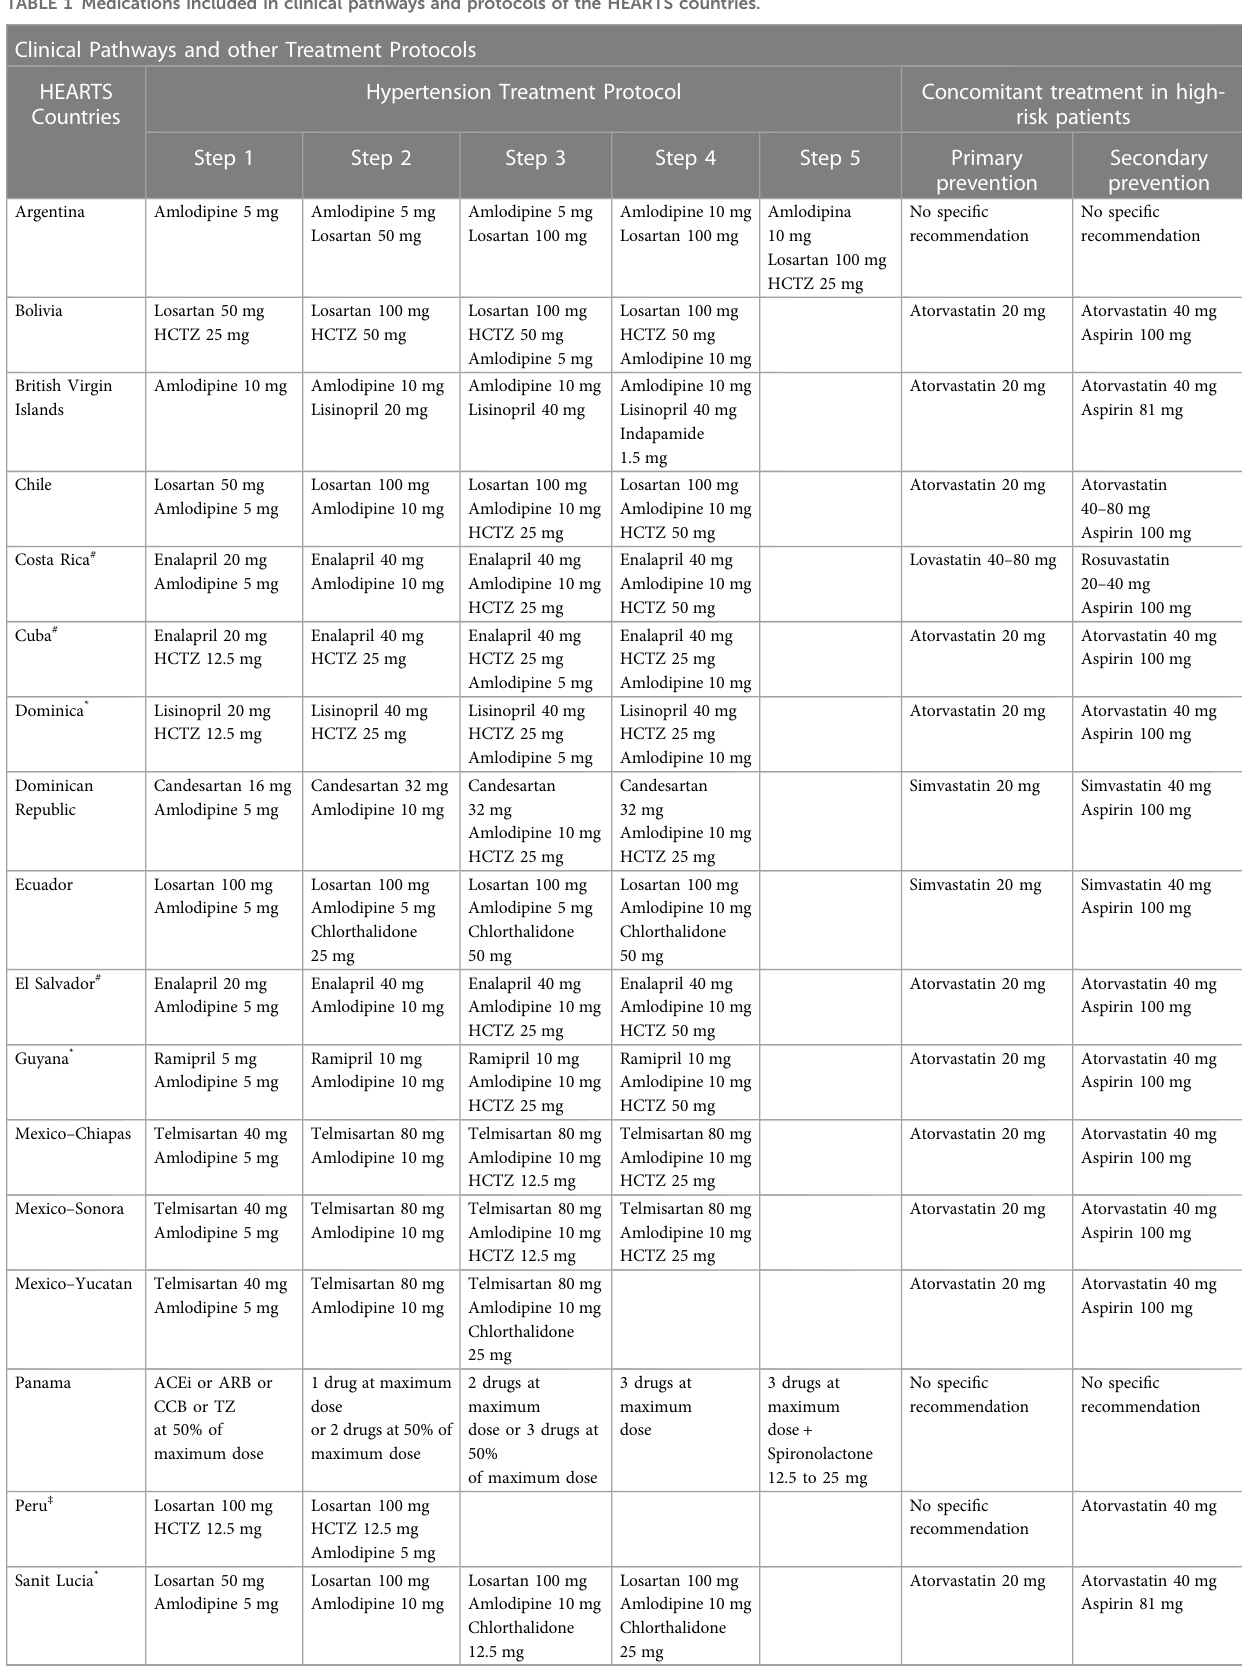
TABLE 1 Medications included in clinical pathways and protocols of the HEARTS countries. Clinical Pathways and other Treatment